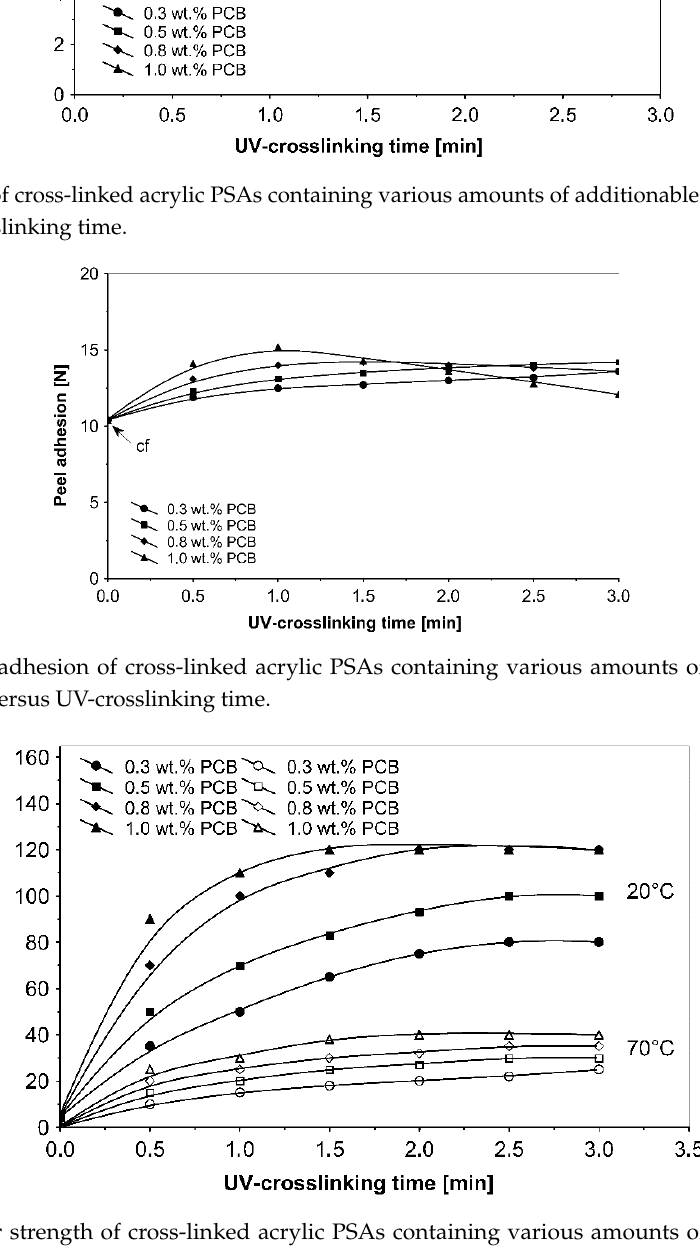
Figure 7. Shear strength of cross-linked acrylic PSAs containing various amounts of additionable photoinitiator versus UV-crosslinking time .